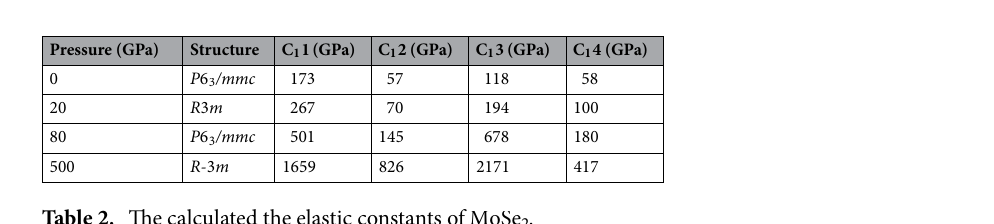
Table 2. The calculated the elastic constants of MoSe 2 .